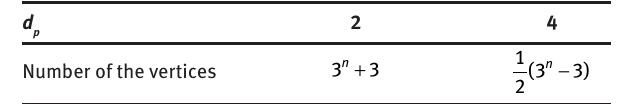
Table 2: Vertex partition of vertex set of SD ( S